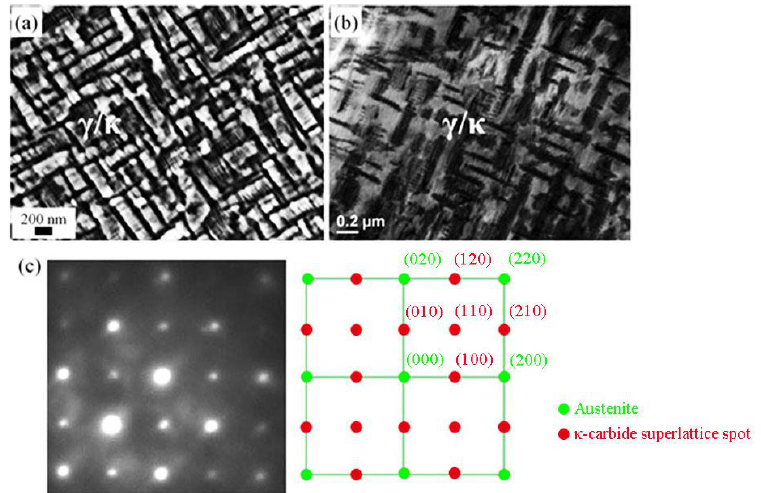
Figure 3. ( a ) SEM image of κ -carbide in austenite, ( b ) TEM bright field image of fine κ -carbide in austenite, and ( c ) TEM diffraction pattern from selected γ/κ area. ( Reprinted with permission from austenite, and ( c ) TEM di ff raction pattern from selected γ / κ area. (Reprinted with permission from [15], copyright Taylor and Francis,